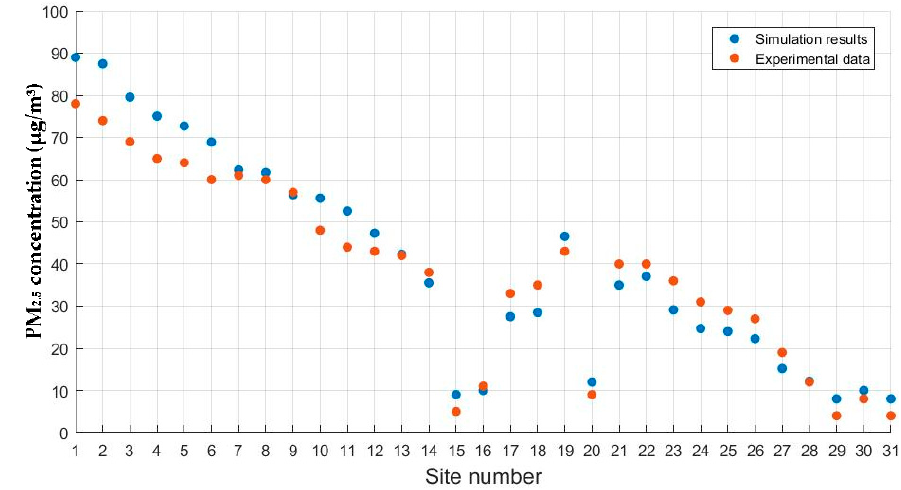
Figure 7. Scatter plots of PM 2.5 concentration at sampling sites.